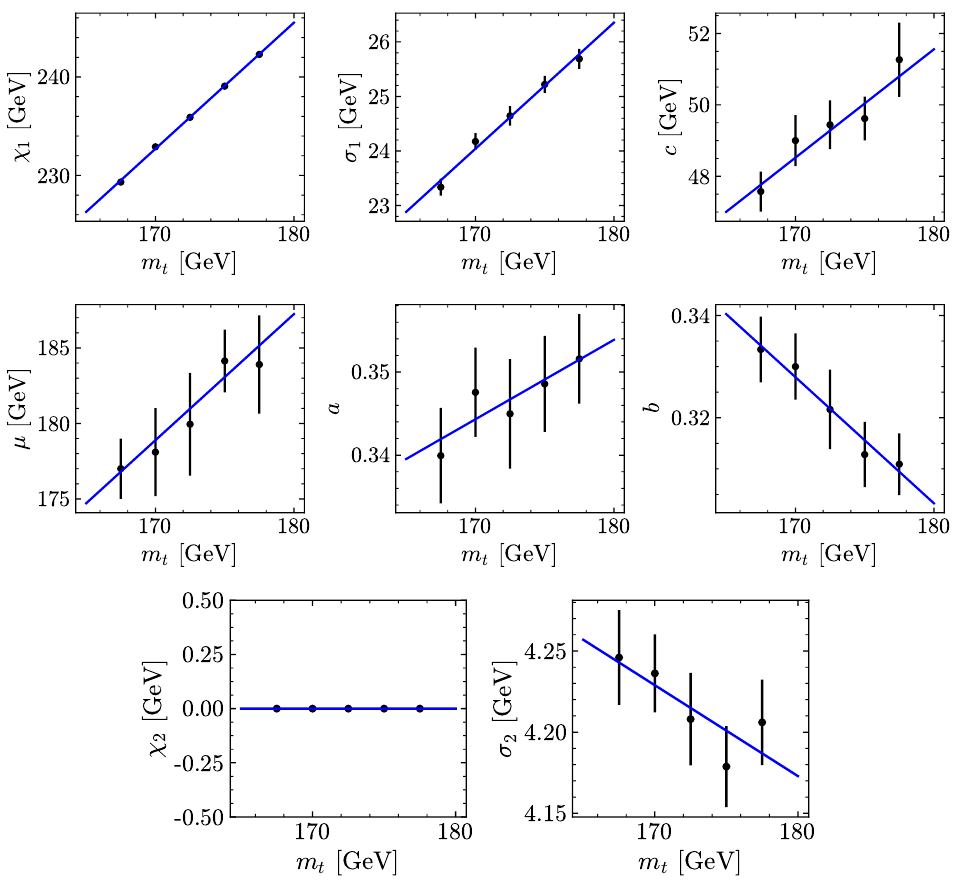
Figure 19 . Here we provide the mean and standard deviation of the best (cid:12)t parameters for the 100 samples derived using the bootstrap procedure. These distributions are then (cid:12)t to a line as a function of m t in order to generate the semi-leptonic